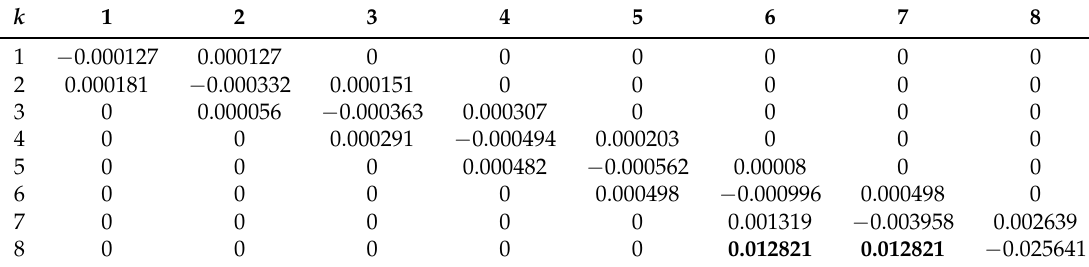
Table 3. Generator matrix—Standard &